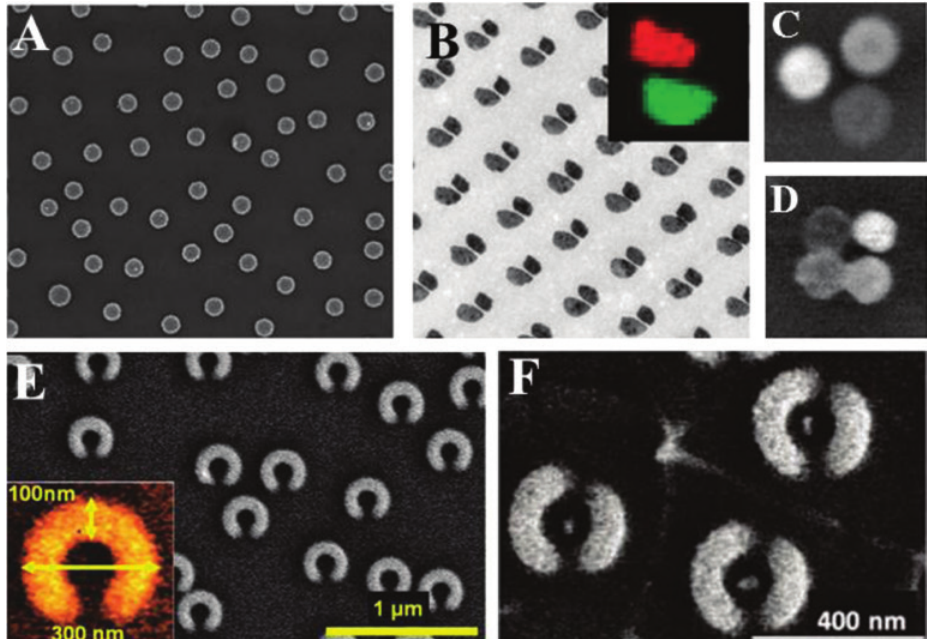
Figure 14: Nanostructures fabricated by using holes as the mask. (A) SEM image of nanodisks fabricated by single OAD based on HCL [135]. (B) SEM image of an Au-Ag heterodimer array fabricated by two OADs [61]. Inset shows elemental mapping of one dimer, with red representing Au and green representing Ag. SEM images of a (C) gold trimer and (D) silver tetramer by three and four depositions, respectively [136]. (E) SEM image of split-rings fabricated by continuous rotation [134]. (F) SEM image of asymmetric double split-ring fabrication by two depositions with continuous rotation